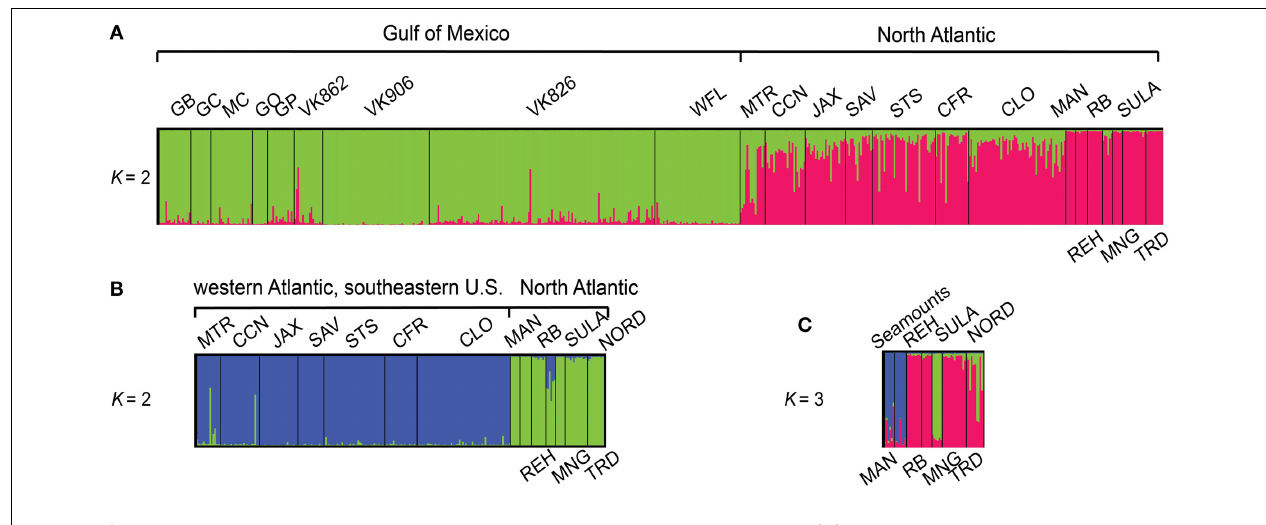
FIGURE 1 | Bar plot showing proportional membership of L. pertusa individuals in K clusters using sequential analyses in the program STRUCTURE. Collection localities, indicated above and below plots, are